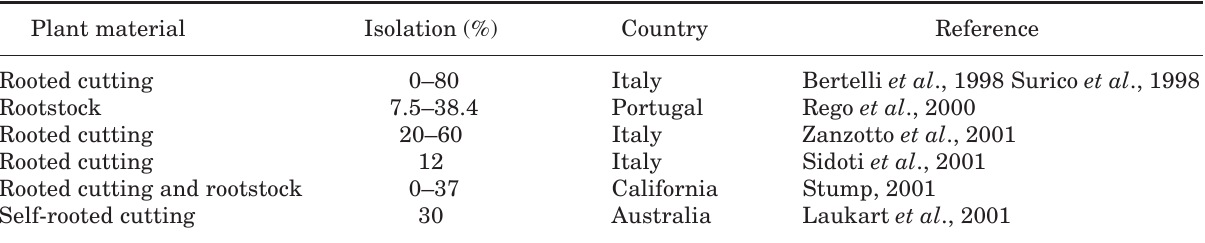
Table 1. Incidence (%) of P. chlamydospora in grapevine propagating material . Plant